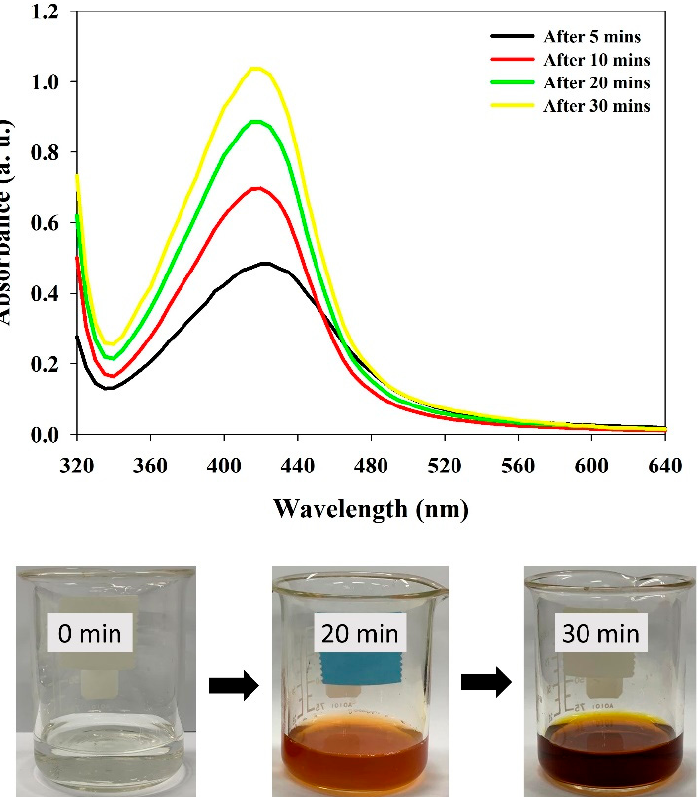
Figure 2. UV-visible absorption spectrum of synthesized Ta-AgNPs and the color changes in the reaction mixture at different time intervals.